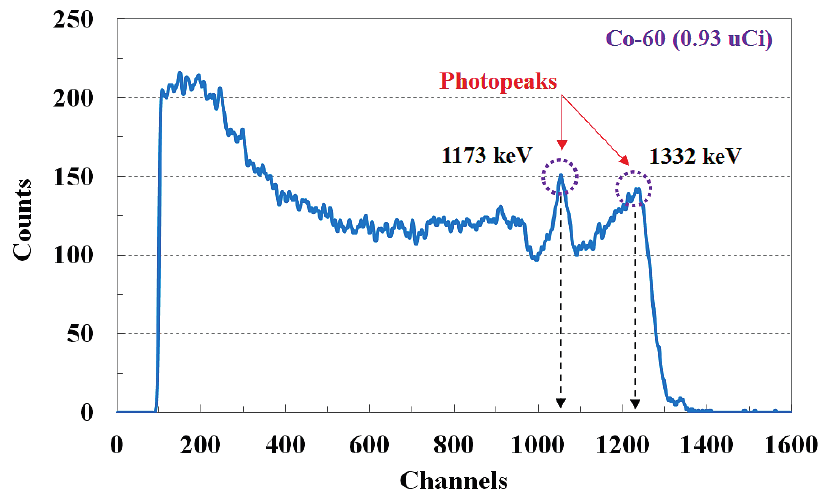
Figure 4. Uncalibrated gamma-ray energy spectrum for Co-60.